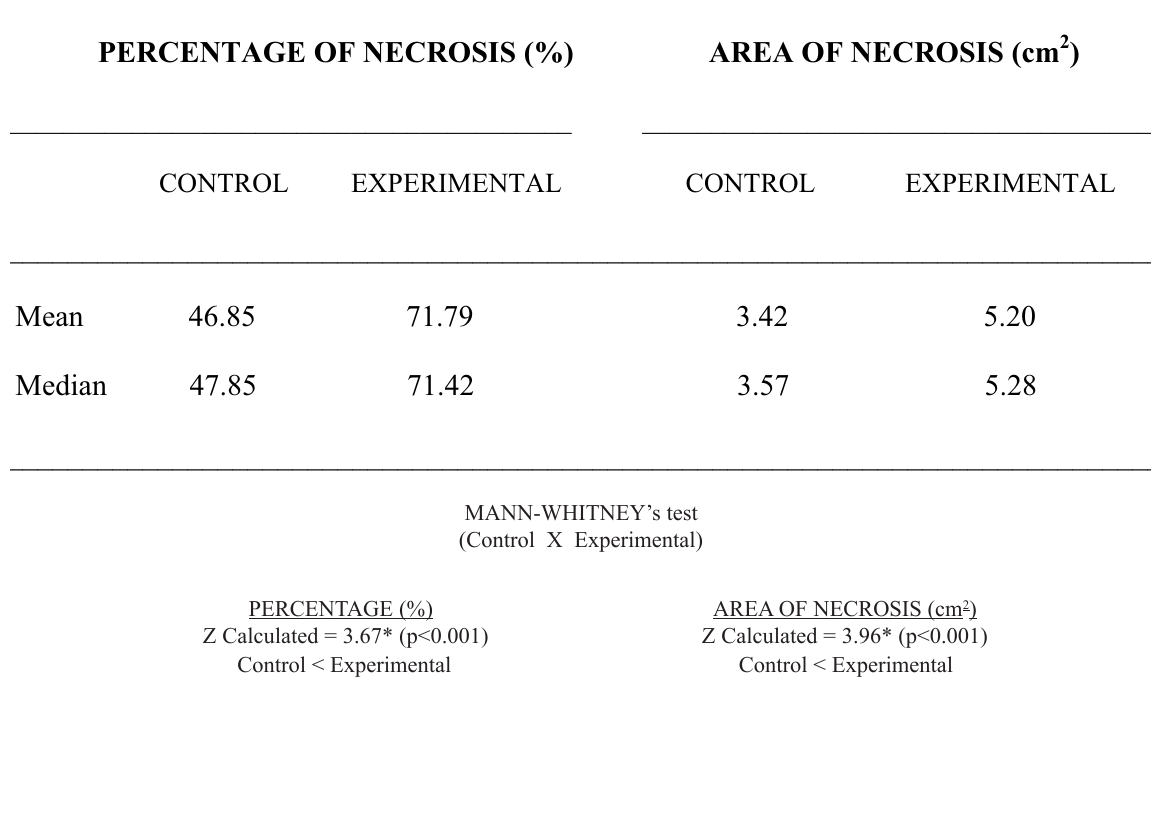
TABLE 1 – Rats of Control (saline) and Experimental (nicotine) groups submitted to the TRAM flap procedure: evaluation of the percentage (%) of necrosis (area of necrosis/ area of the flap X 100) and area of necrosis in square centimeters (cm 2 )